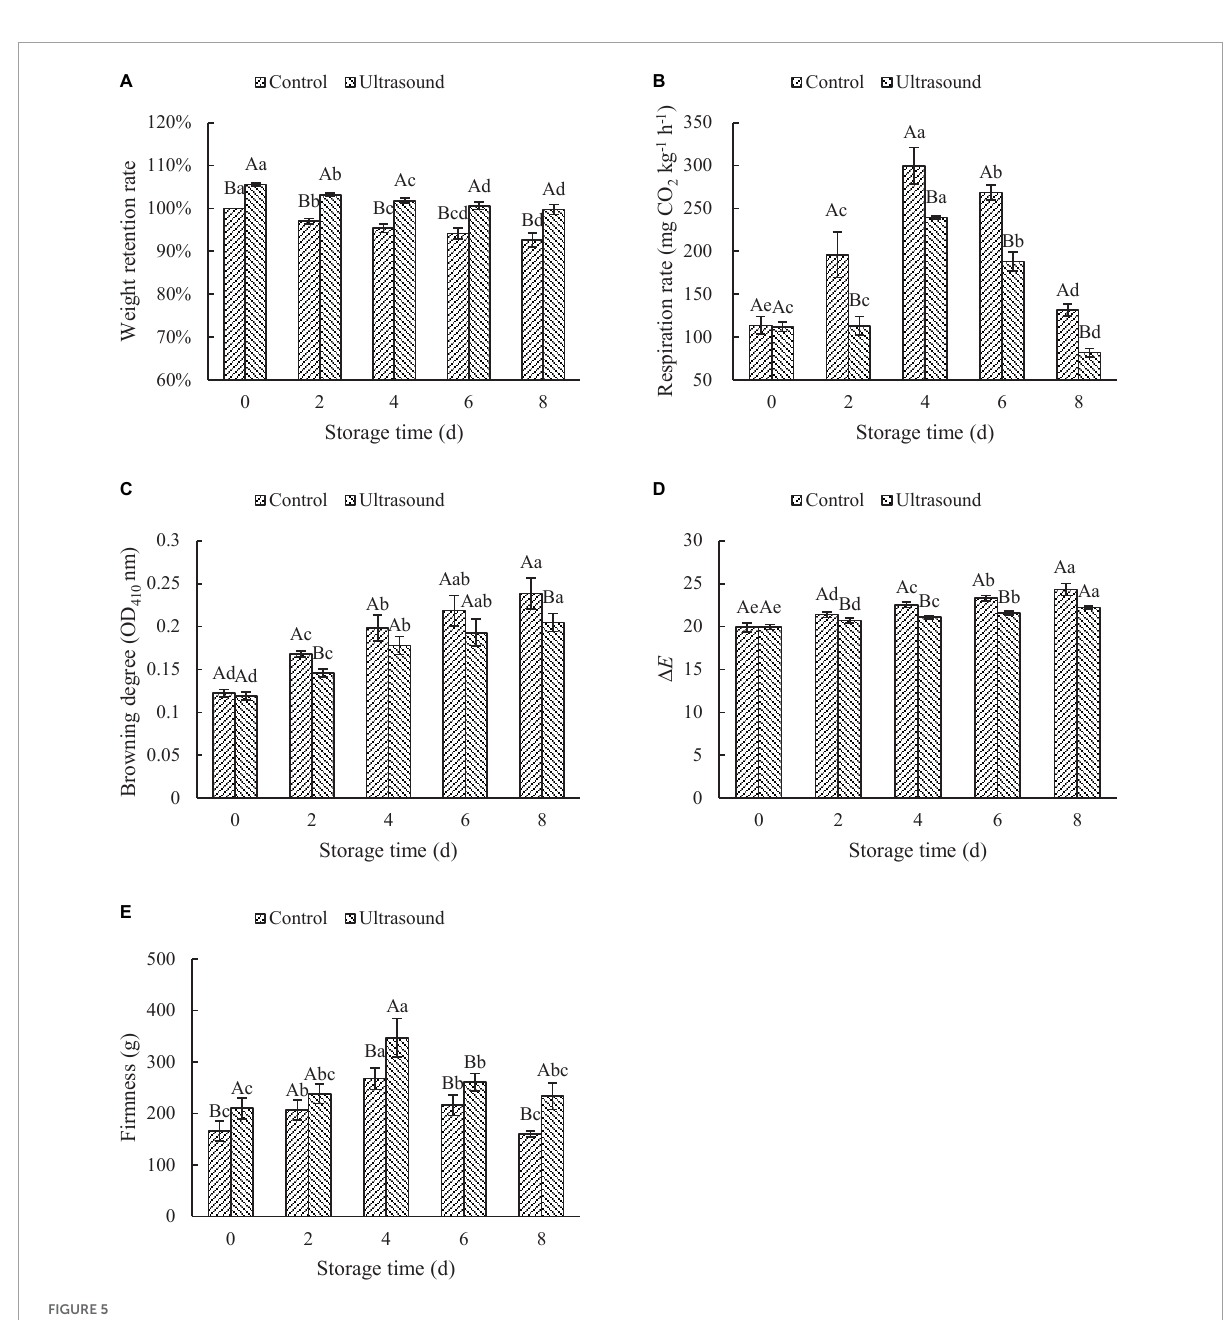
FIGURE5 Effects of ultrasonic washing on the weight retention rate (A) , respiration rate (B) , color (C,D) , and firmness (E) . The results represent the means of three triplicates ± standard deviations. Different capital letters mean that the effects of different treatments for the same day are significantly different ( P < 0.05); different lowercase letters mean that the effects of storage times for the same treatment are significantly different ( P < 0.05). Control: fresh-cut red cabbages were washed with sterile distilled water; ultrasound treatment: ultrasonic frequency mode of 28 ± 2 kHz, ultrasonic power density of 60 W/L, frequency cycle time of 400 ms, and ultrasonic time of 20 min.